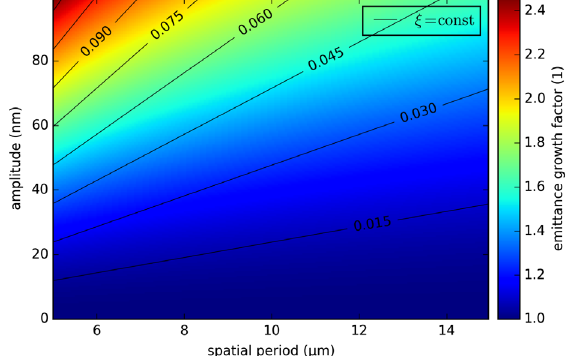
FIG. 6. Contour plot of the emittance growth factor. Note that the solid black lines in the plot stand for different aspect ( ξ ) of the surface, but not for contour lines for the emittance growth factor.